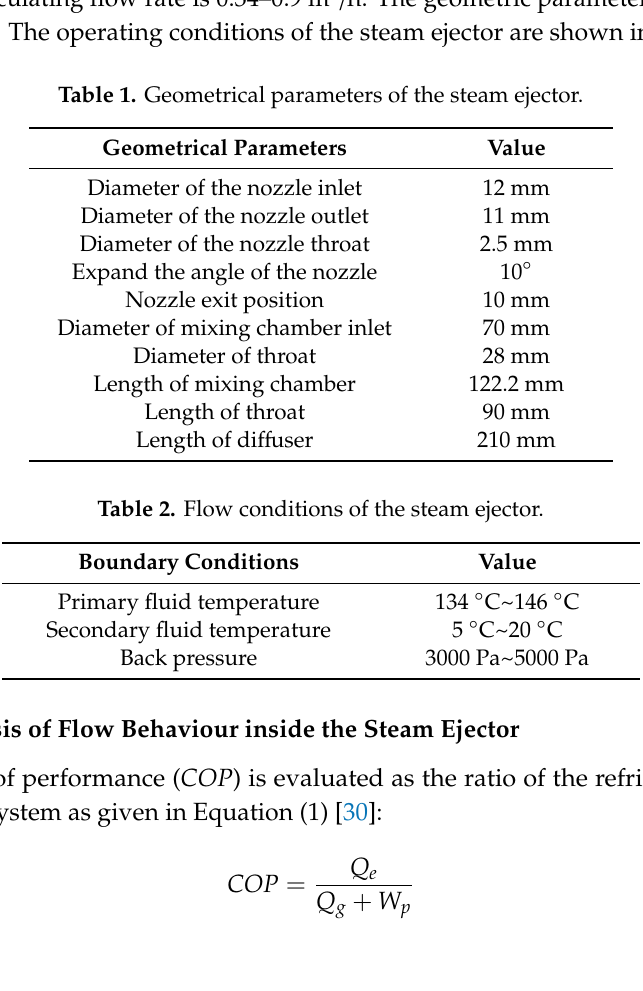
Table 1. Geometrical parameters of the steam ejector.